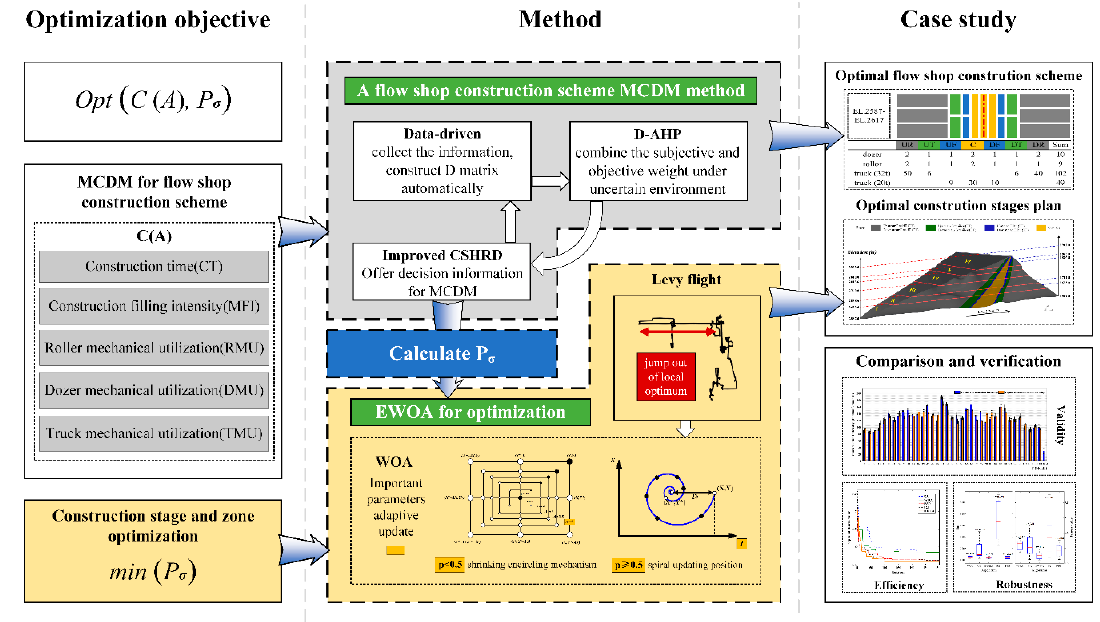
Figure 2. Research